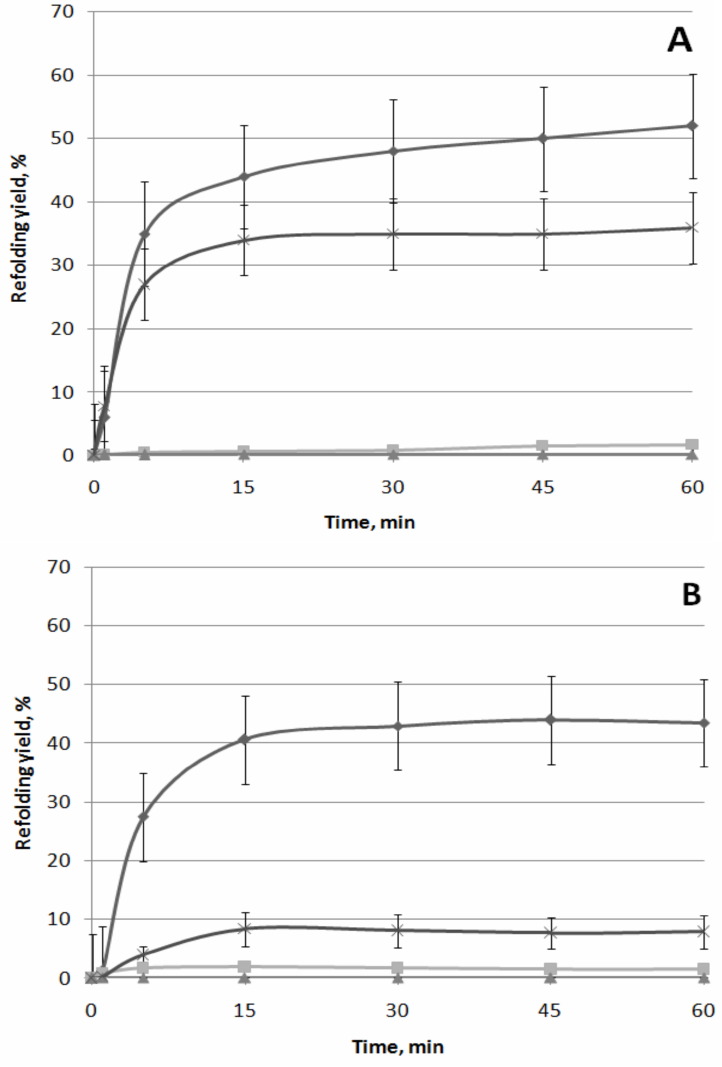
Figure 2. Luminescent response of strain E. coli MG1655 (pKatG’::lux) to hydrogen peroxide ( A ), ( − )-limonene ( B ), and (+)- α -pinene (C). Time course of mean values of light emission (in RLU) in the presence of different chemical concentrations ( A , B ): ( ) 0 µM (black diamond—Control), ( ) 1 Figure 9. Effect of ( − )-limonene, (+)- α -pinene, and CCCP on the kinetics of refolding of heat- µM (gray square), ( ) 5 µM (dark triangle), (×) 25 µM (black cross), (  ) 50 µM (gray asterisk), and inactivated P. leiognathi luciferase in the wild-type strain ( E. coli BW25113 (pLeo1)) ( A ) and ∆ ibpB mutant strain( E. coli JW3663 ibpB::kan (pLeo1)) ( B ). ( ( ) 100 µM (light circle); (C): ( ) 0 µM (black diamond—control), ( ) 5 µM (light square), ( ) 50 µM (gray triangle), ( ) 100 µM (black circle). ( (cid:4) ) 10 µ M of ( − )-limonene, ( (cid:78) ) 50 µ M of CCCP. The ordinate axis shows the enzymatic activity of luciferase in the percentage of the initial level. The abscissa axis shows the time of incubation at 22 ◦